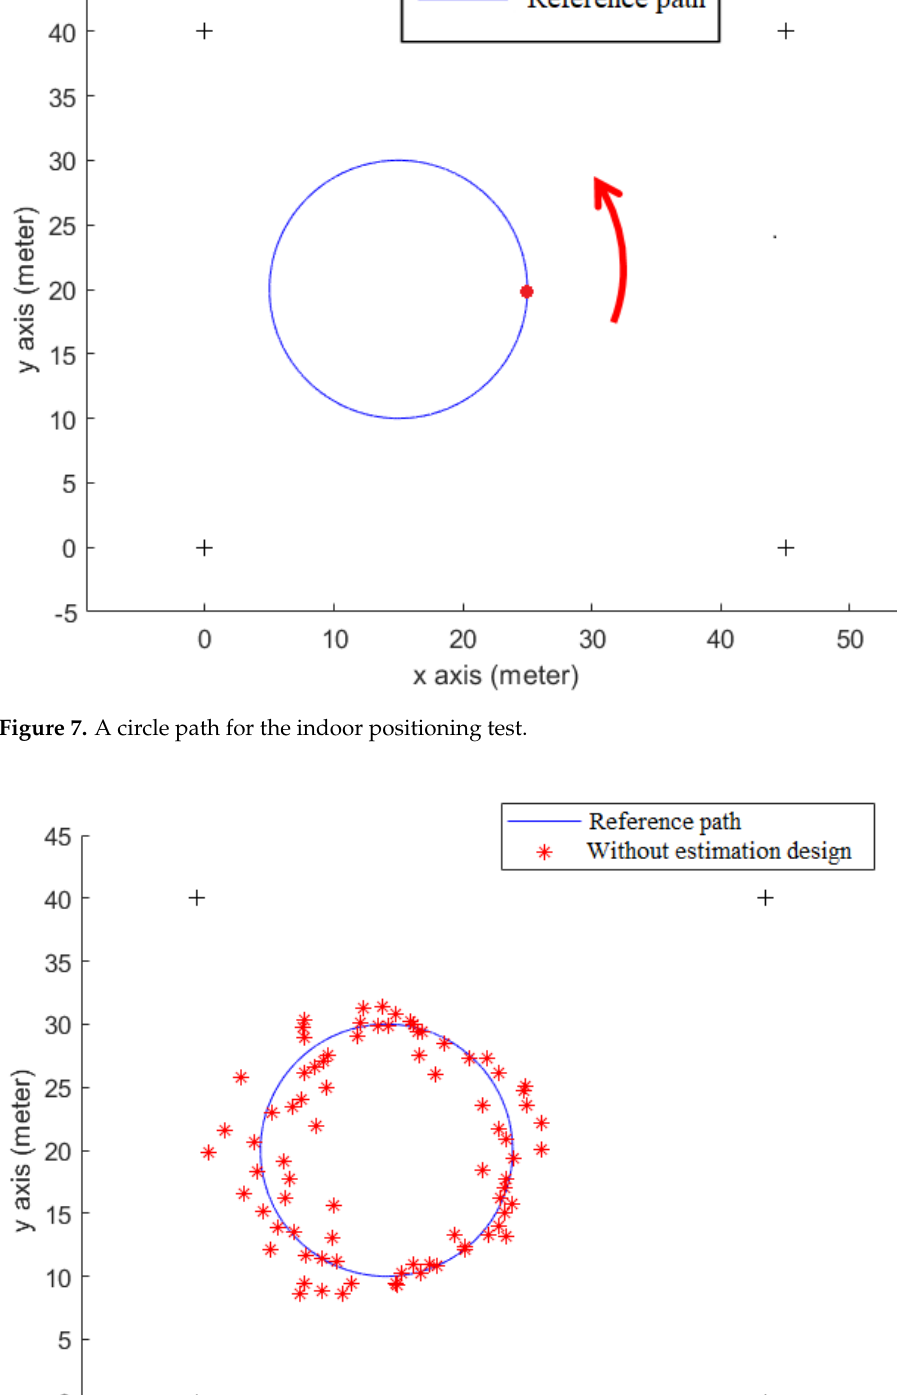
Figure 8. The positioning result without using any estimation design.